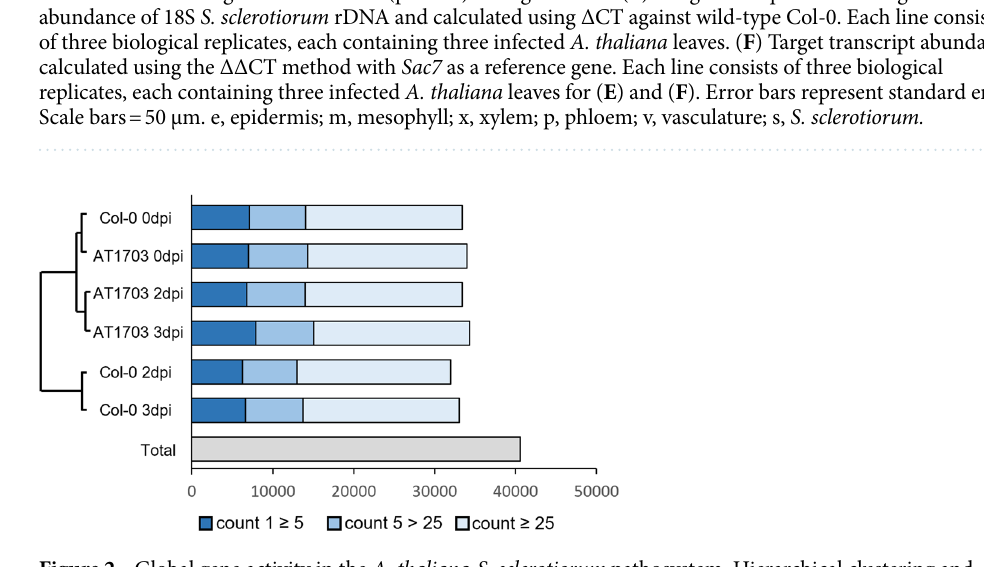
Figure 2. Global gene activity in the A. thaliana-S. sclerotiorum pathosystem. Hierarchical clustering and global gene activity of wild-type Col-0 and AT1703 at 0-, 2- and 3-days post inoculation . Number of transcripts detected across all treatments were identified through RNA sequencing. Transcripts with a count value > 1 are considered detected. Detected transcripts are subdivided into low (1 ≥ 5), moderate (5 > 25), or high (≥ 25) abundance